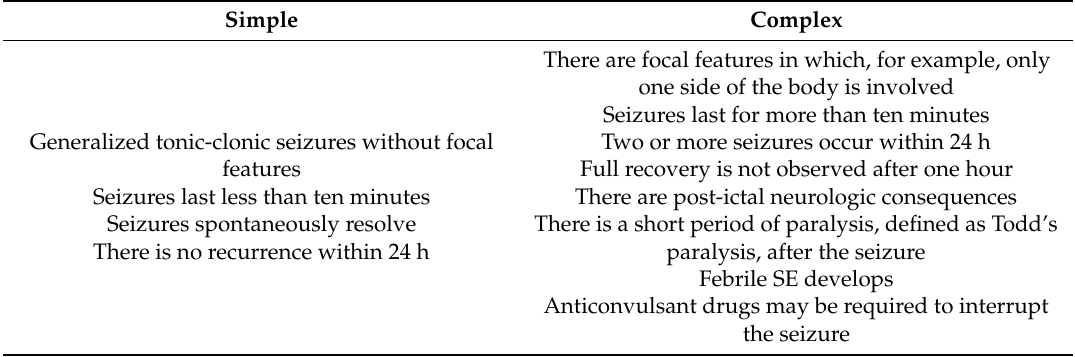
Table 1. Clinical characteristics of simple and complex febrile seizures